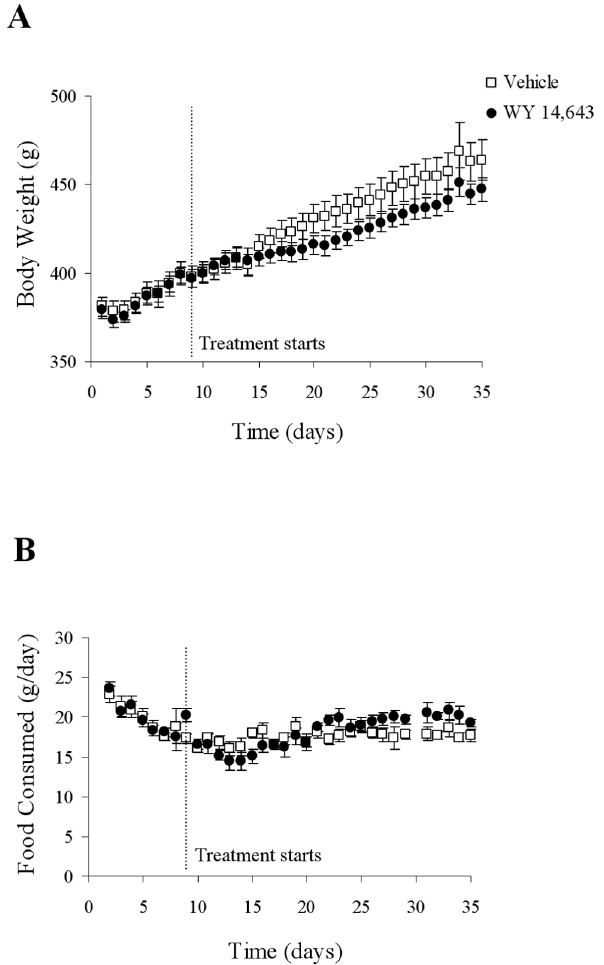
Fig. 1. Body weight development (A) and consumption of high-fat diet (B). Rats were treated per orally with WY 14,643 (n 5 10) or vehicle (n 5 10). Values are given as means ¡ SEM.